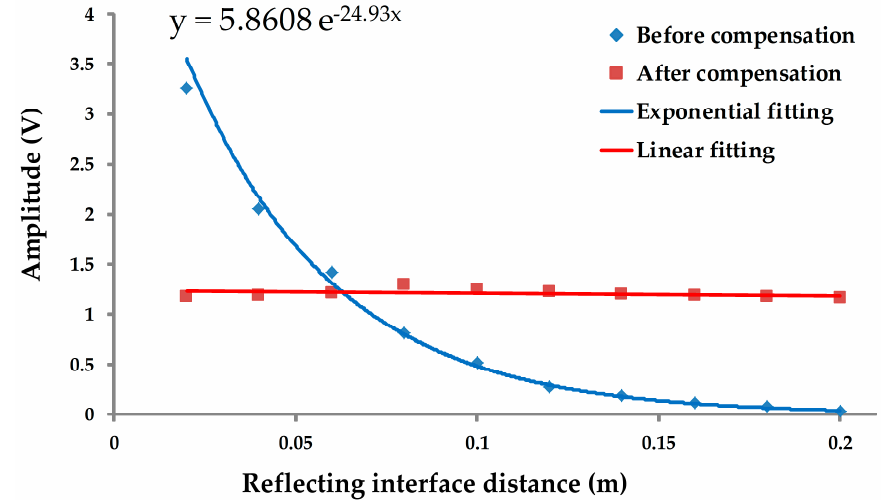
Figure 12. Comparison chart of the signal amplitudes (peak-to-peak) before and after compensation.